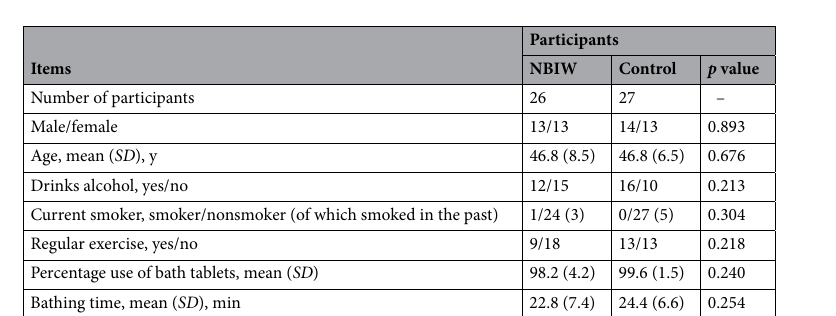
Table 2. Background of the participants and use of bath tablets. NBIW neutral bicarbonate ionized water. No significant difference was found between control and NBIW groups in any item. Age, use of test sample, bathing time: Wilcoxon rank sum test. Other items: Chi-square test.